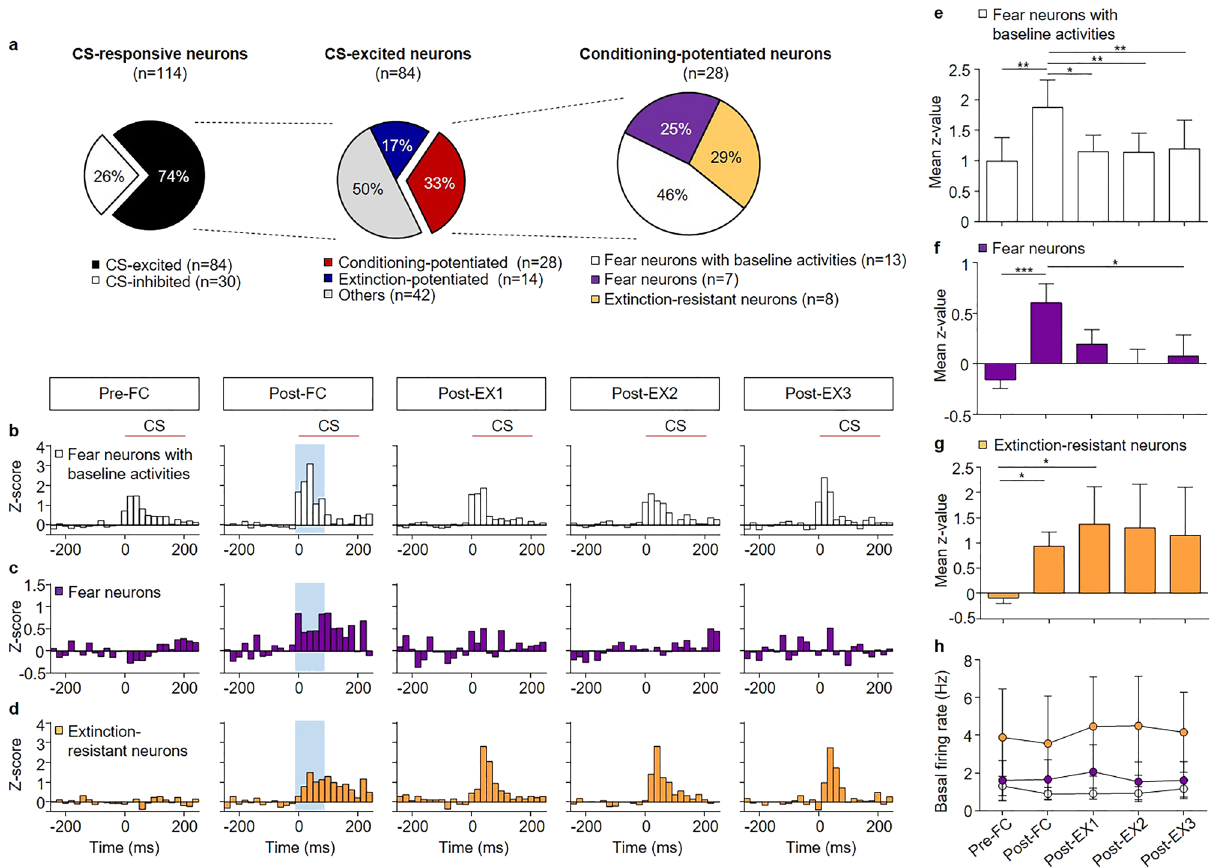
Figure 4. Distinct sub-populations of conditioning-potentiated neurons encode different facets of fear conditioning. ( a ) Pie chart showing the percentage of CS-excited neurons among the CS-responsive neurons (left), the percentage of conditioning-potentiated neurons among the CS-excited neurons (middle), and the percentage of three types of conditioning-potentiated neurons (right). ( b ) Z-score PETH of fear neurons with baseline activities (n = 13, 46% of conditioning-potentiated neurons). ( c ) Z-score PETH of fear neurons (n = 7, 25% of conditioning-potentiated neurons). ( d ) Z-score PETH of extinction-resistant neurons (n = 8, 29% of conditioning-potentiated neurons). ( e–g ) The mean z-score comparisons of ( e ) fear neurons with baseline activities, ( f ) fear neurons, ( g ) extinction-resistant neurons. ( h ) Comparison of basal firing rates of fear neurons with basal activities (white circle), fear neurons (purple circle) and extinction-resistant neurons (orange circle) across all behavioral sessions. * p < 0.05; ** p < 0.01; *** p <